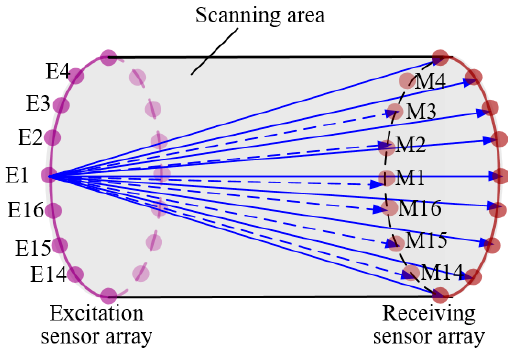
Figure 10. Cross-hole scanning structure.